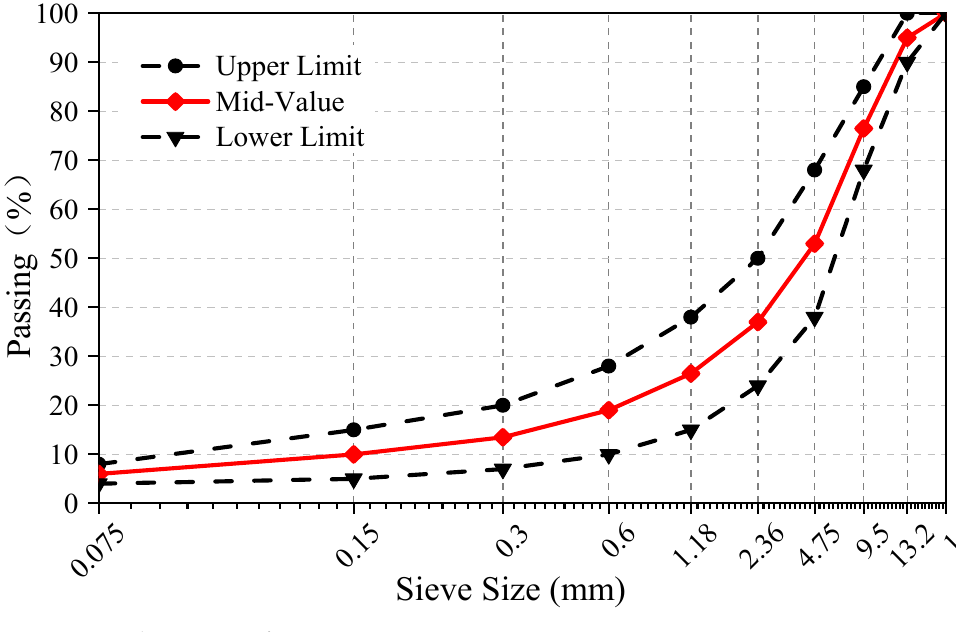
Figure 2. Gradation curve for AC-13.